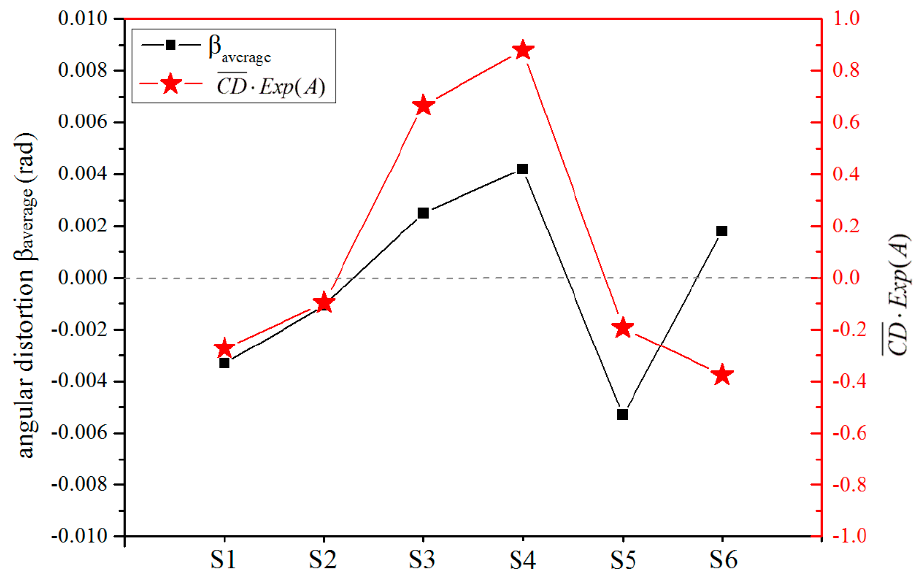
( ) CD Exp A ⋅ of cases S1–S6.